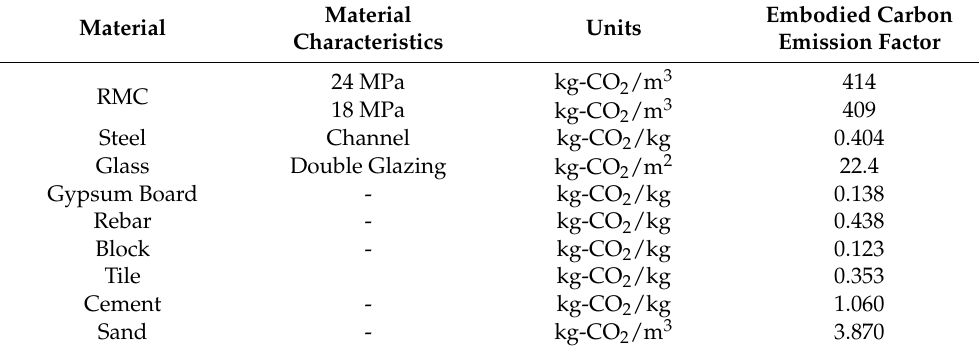
Table 3. Embodied carbon emission factors in the production phase for major construction